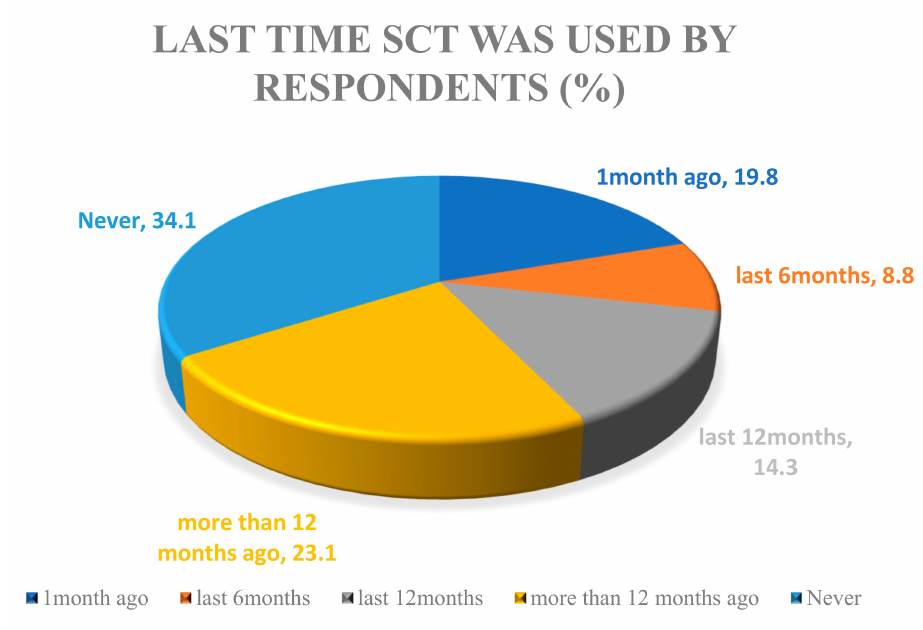
Figure 3. Last time the SCT technique was